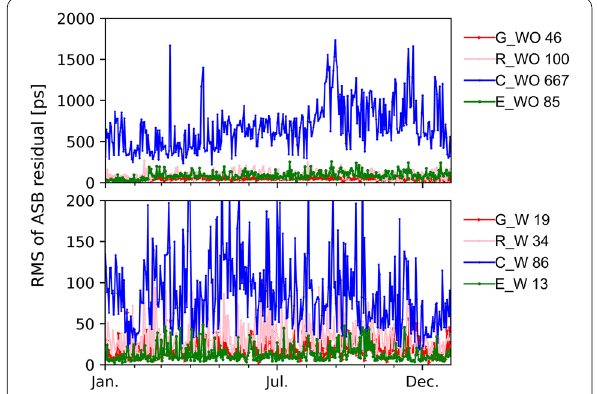
Fig. 8 Daily RMS of ASB residuals for multi-GNSS combined clock solutions with (W) and without (WO) ASB correction. ‘G’, ‘R’, ‘C’, ‘E’, and ‘J’ in the legend indicate GPS, GLONASS, BDS-2, and Galileo, respectively. The values in the legend indicate the median RMS